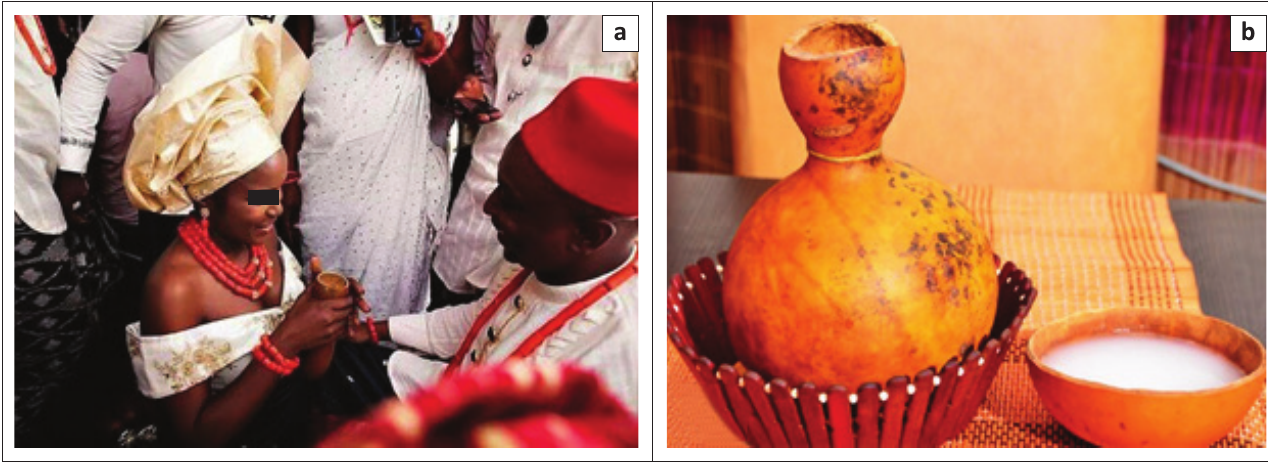
FIGURE 3: Bride presenting palm wine in a small gourd to the groom during an igbo traditional wedding ceremony (a) and A typical palmwine in a bottle gourd and served in a smallcalabash (b).